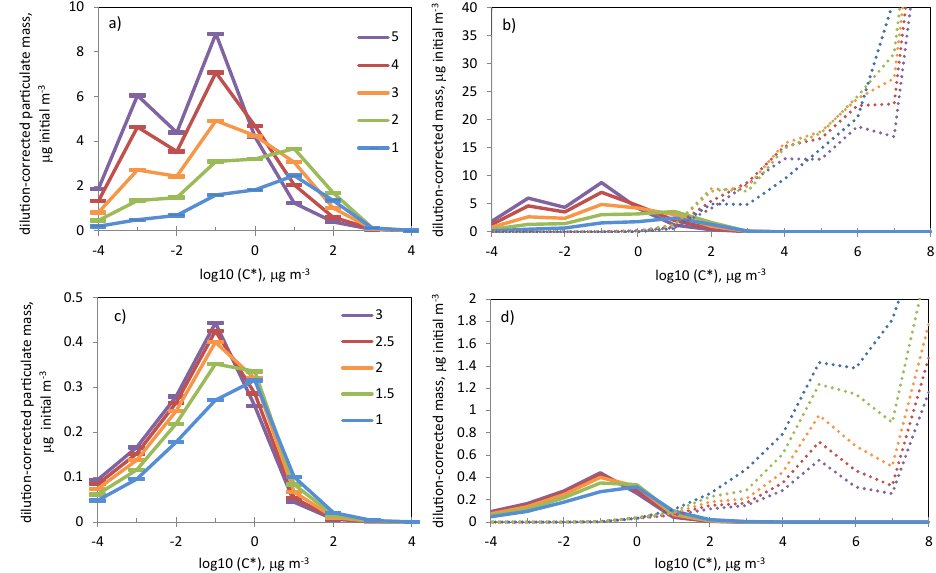
Figure 3. Time evolution of volatility distributions. (a, b) Urban case and (c, d) forest case. Solid lines, particle phase; dotted lines, gas phases. Colors represent different times (see key): whole numbers are midnight values (e.g., “1” is midnight between days 1 and 2), and half-day numbers are noon values (e.g., “1.5” is noon on day 2). The volatility continuums have been binned in decadal increments for ease of comparison with so-called volatility basis set (VBS)